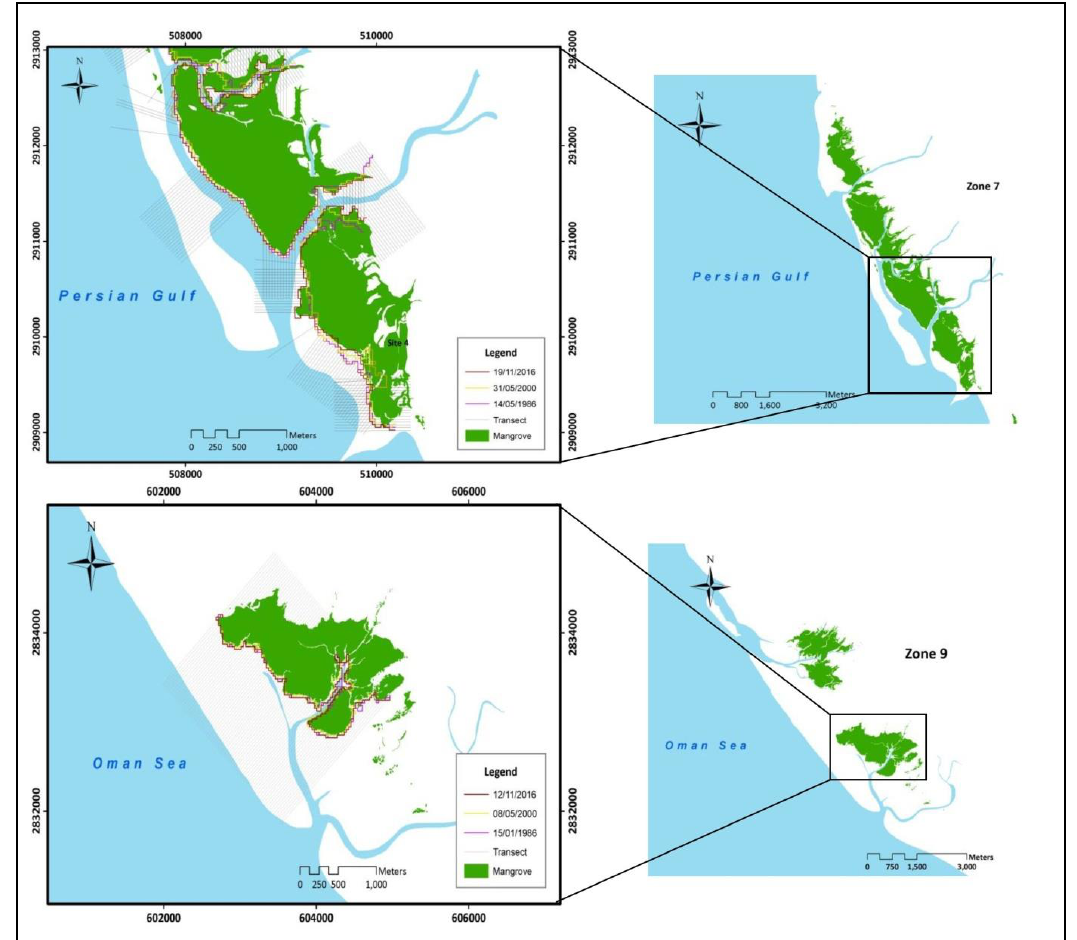
Figure 3. Shorelines changes of mangroves in Tiab habitat during 30-year period